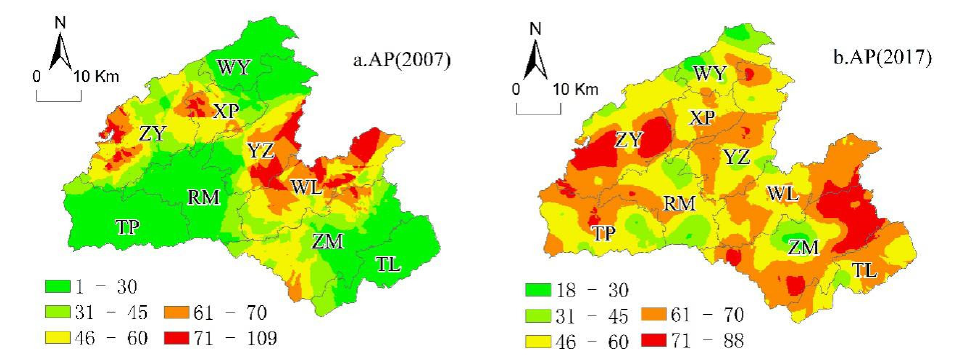
Figure 6. Ordinary kriging distribution maps for ( a ) 2007 AP and ( b ) 2017 AP. (3) Spatial Distribution of Soil AK in 2007 and 2017 In 2007, approximately 21.69% and 47.24% of the land were at the low-to-medium level of soil AK. Moreover, 21.0% and 8.86% of the land were at the high and highest level of soil AK, respectively. In 2007, the proportion of land decreased by −0.68%, −12.71%, and